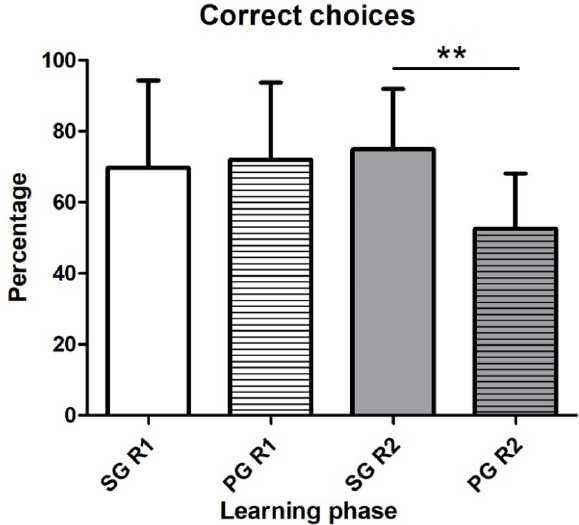
Figure 2. Mean ± SD of the percentage of correct answers in the Learning phase. R1: Round 1, R2: Round 2. SG: supplement group, PG: placebo group. p value: ** p < 0.001.